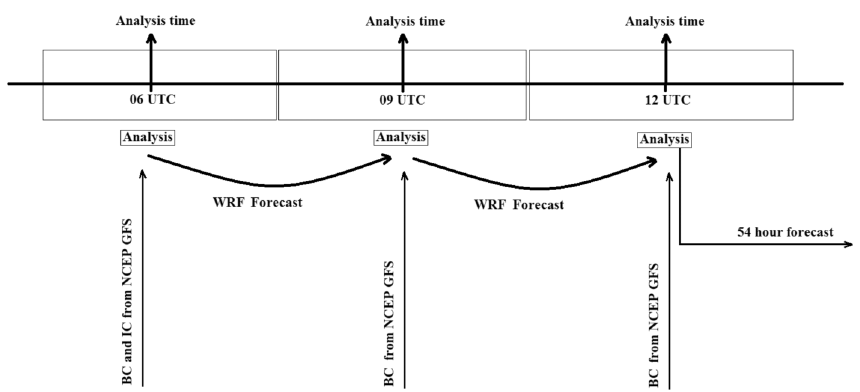
Figure 2. The structure of cycling 3DVAR data assimilation with 3h time windows.